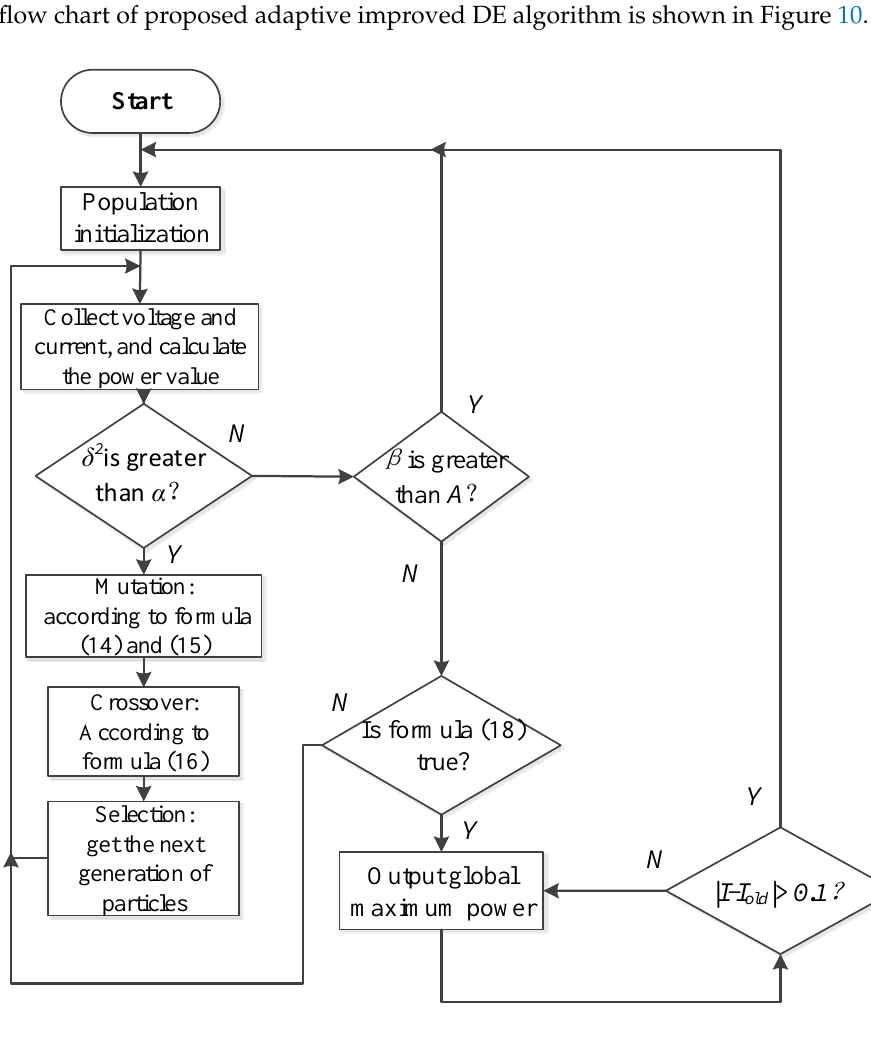
Figure 10. MPPT control flowchart of PV array with improved DE algorithm.